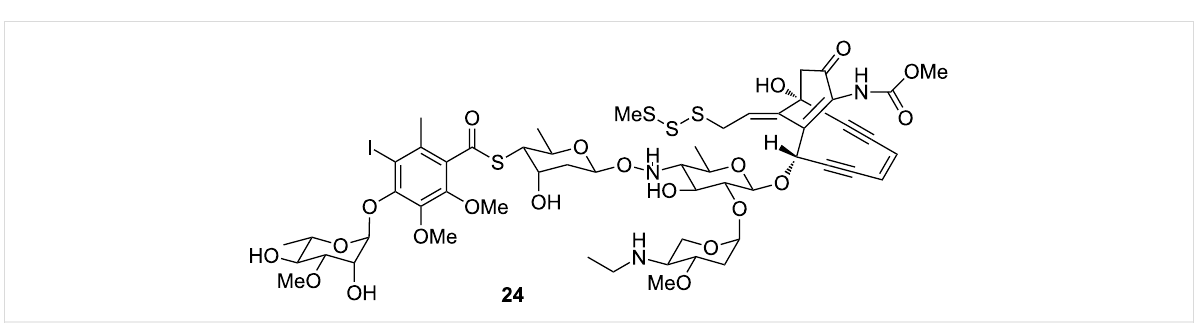
FeSO 4 ·7H 2 O, 1 g L − 1 MnCl 4 ·4H 2 O, and 1 g L − 1 ZnSO 4 ·7H 2 O was added, followed by sterilisation at 121 °C for 20